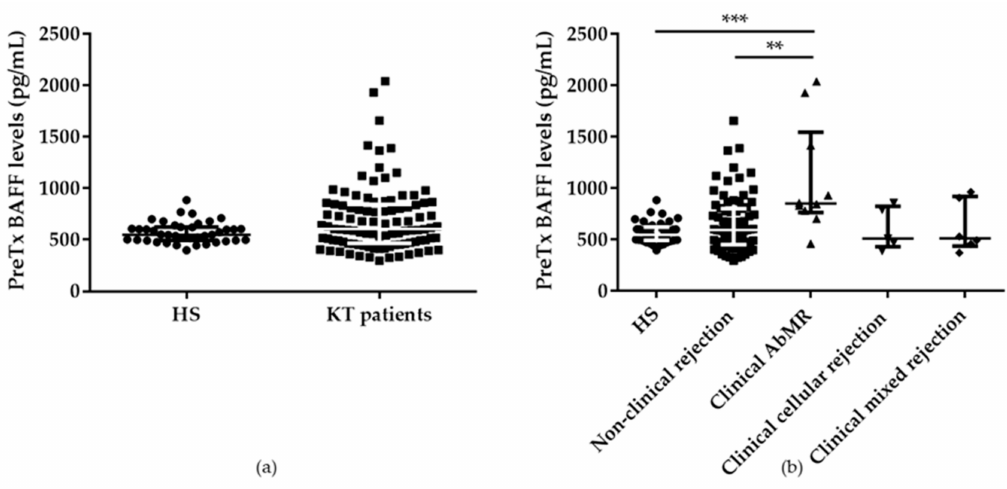
Figure 1. ( a ) No significant di ff erences were found in the comparison of pretransplant serum BAFF levels between kidney transplant (KT) patients ( n = 109) and healthy subjects (HS; n = 40). ( b ) Statistically significant di ff erences in pretransplant serum BAFF levels between kidney transplant